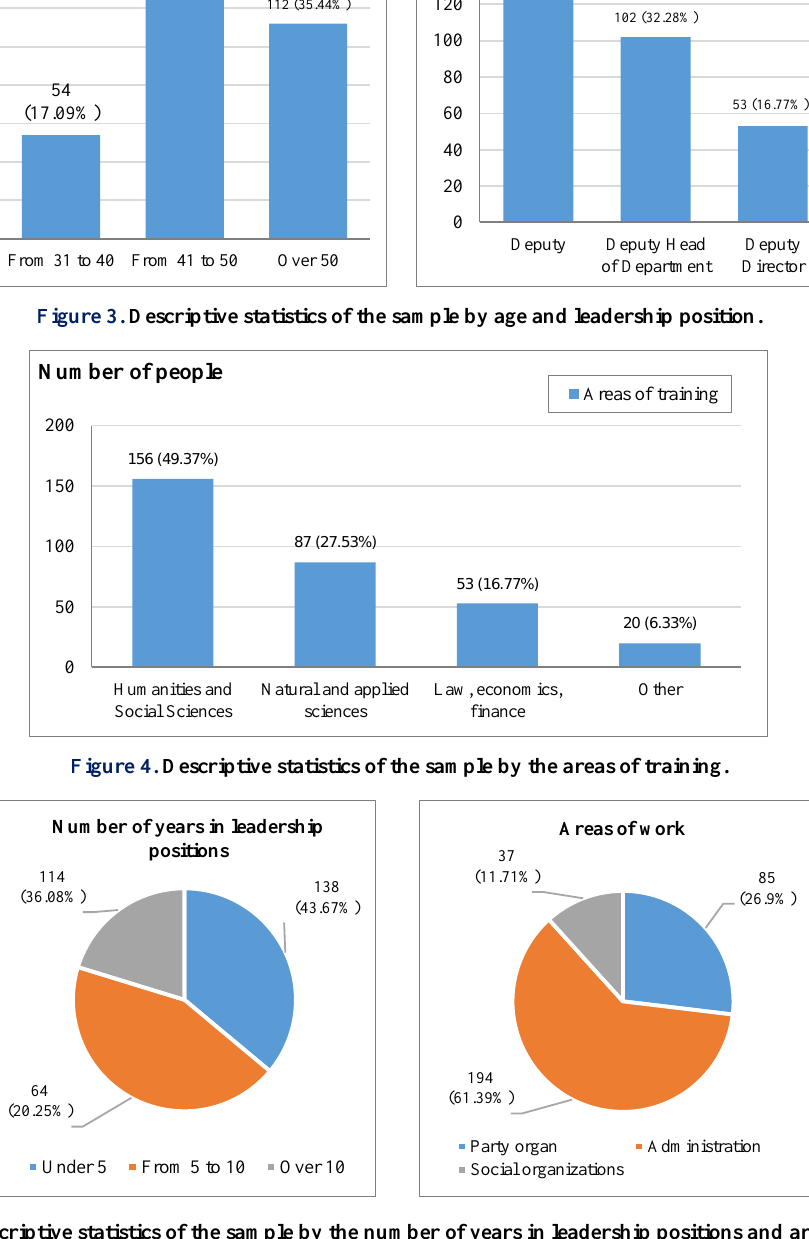
Figure 5. Descriptive statistics of the sample by the number of years in leadership positions and areas of